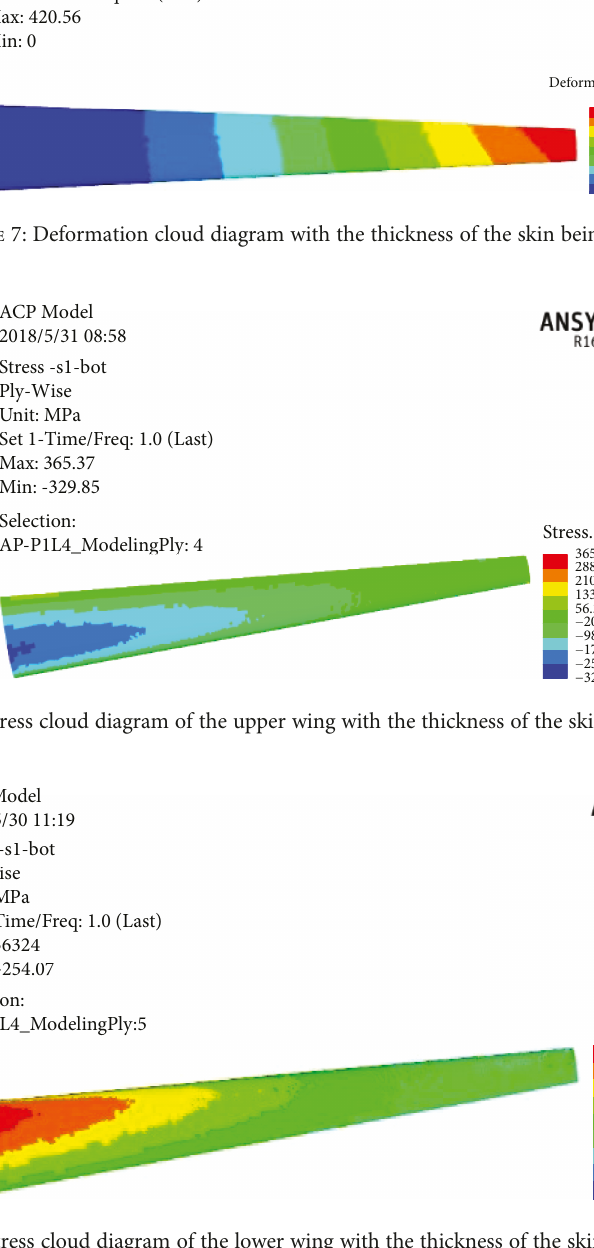
Figure 9: Stress cloud diagram of the lower wing with the thickness of the skin being 12